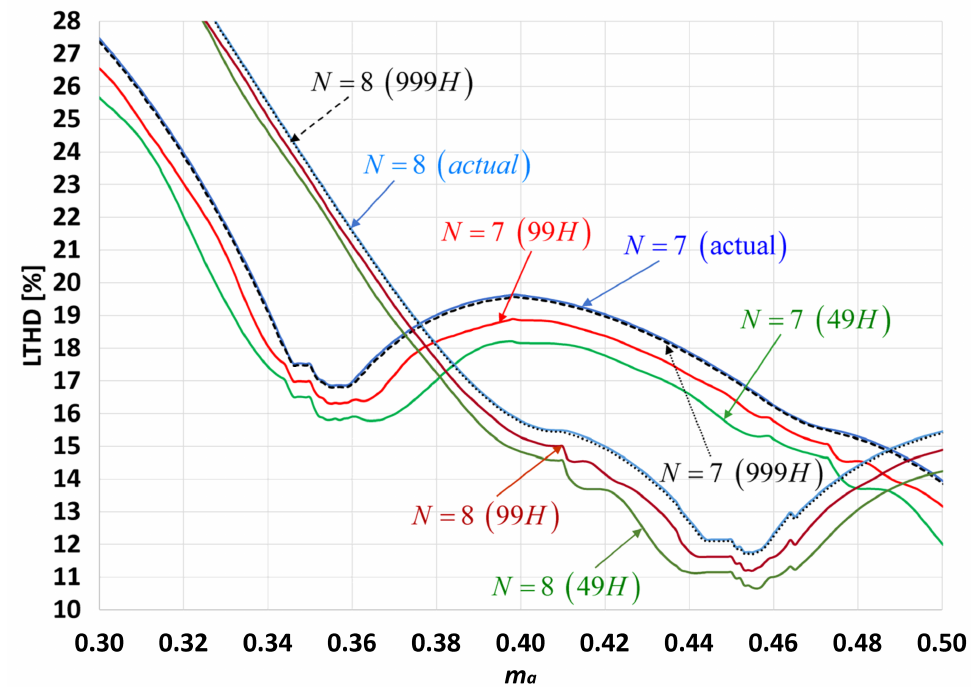
Figure 3. Minimum LTHD for N = 7, 8: proposed vs. recommended 49, 99, and 999 harmonics